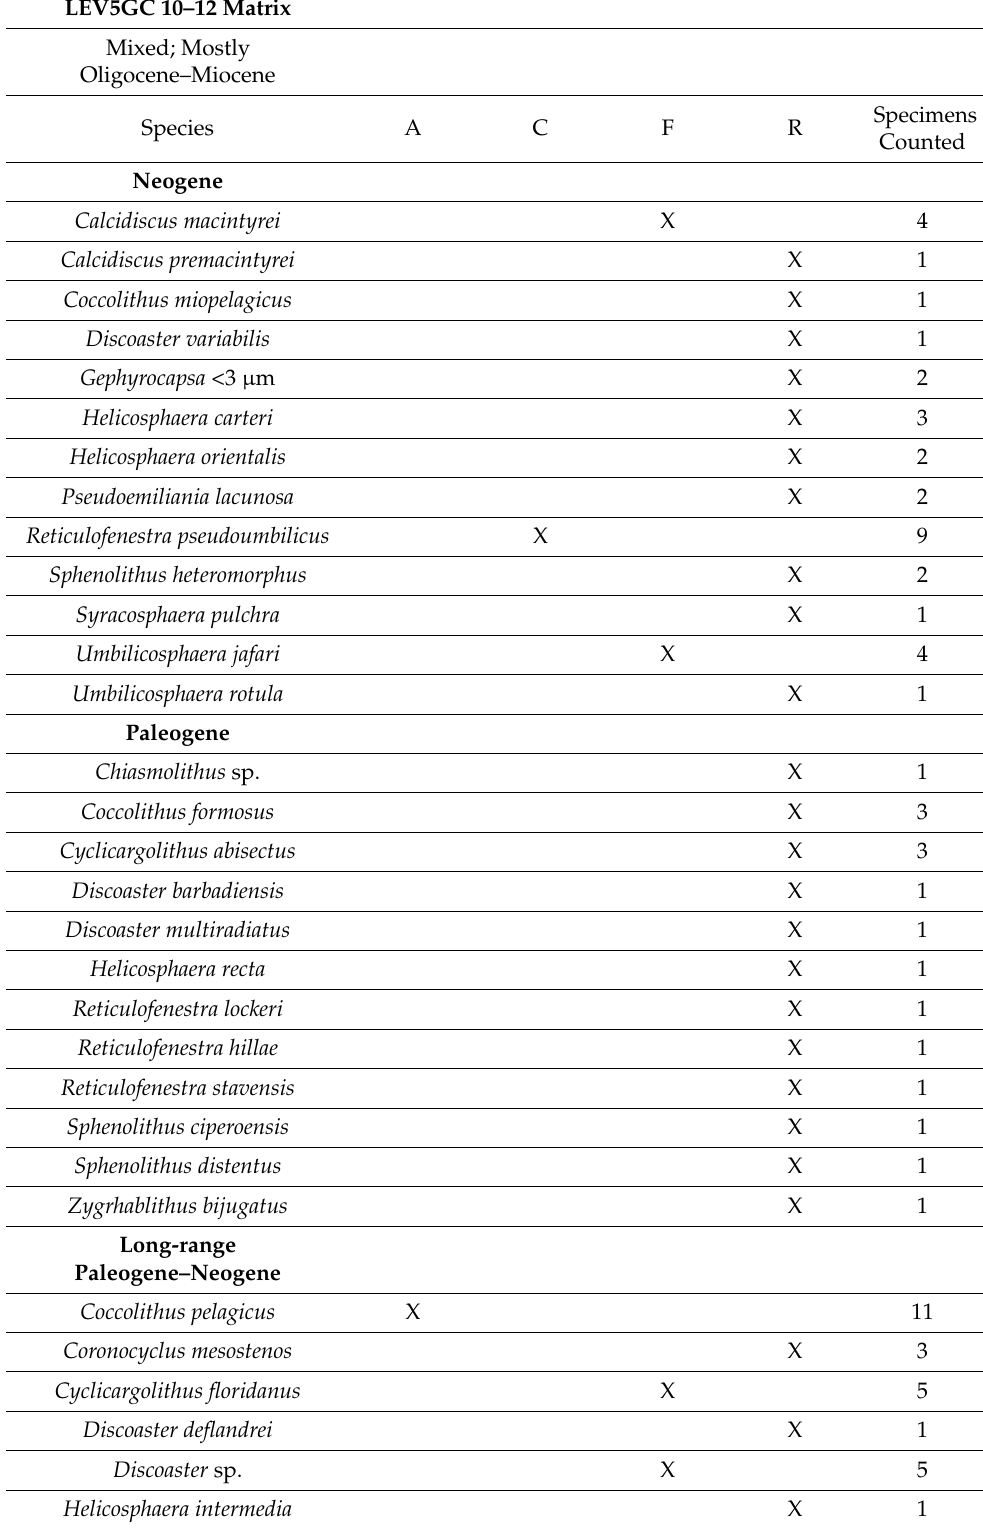
Table A17. Moscow